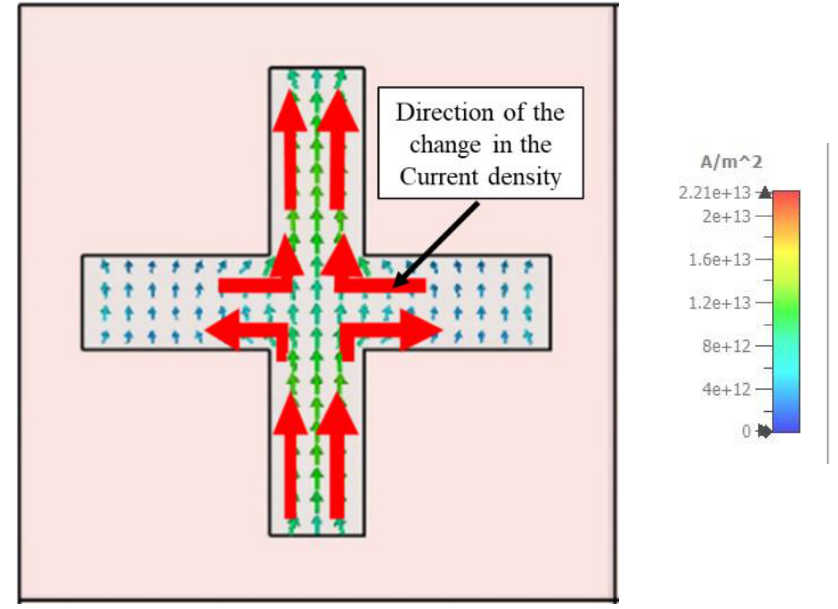
Figure 17. The current mode of the metal layer at 1150 nm wavelength.